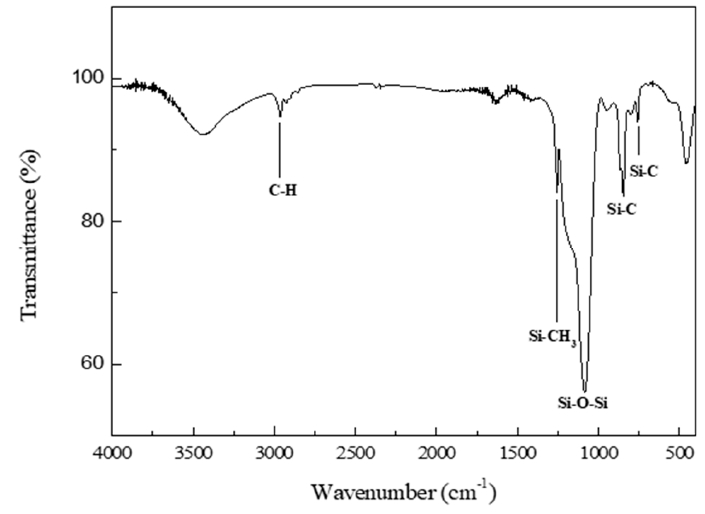
Figure 7. FTIR spectrum of the surface-modified silica aerogel.